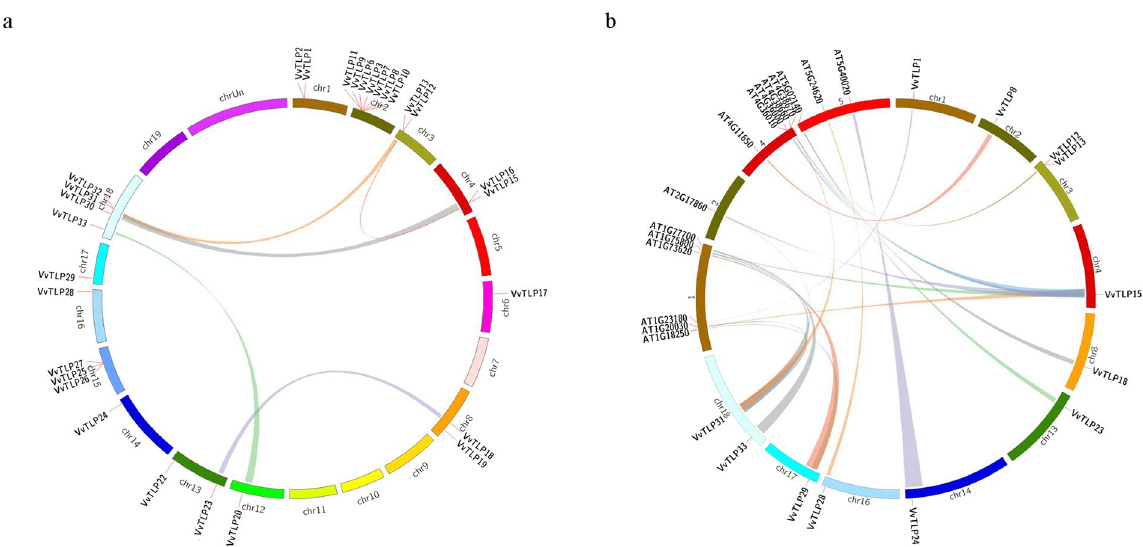
Figure 2. Chromosome distribution and synteny analysis of grape and Arabidopsis thaliana TLP genes. ( a ) Chromosomes 1–19 are shown in different colors in a circular diagram. The approximate distribution of each VvTLP gene is marked with a short red line on the circle. Colored curves denote the details of syntenic regions between grape TLP genes. ( b ) The chromosomes of grape and A . thaliana are depicted as a circle. The approximate distribution of each AtTLP and VvTLP gene is marked with a short red line on the circle. Colored curves denote the details of syntenic regions between grape and A . thaliana TLP